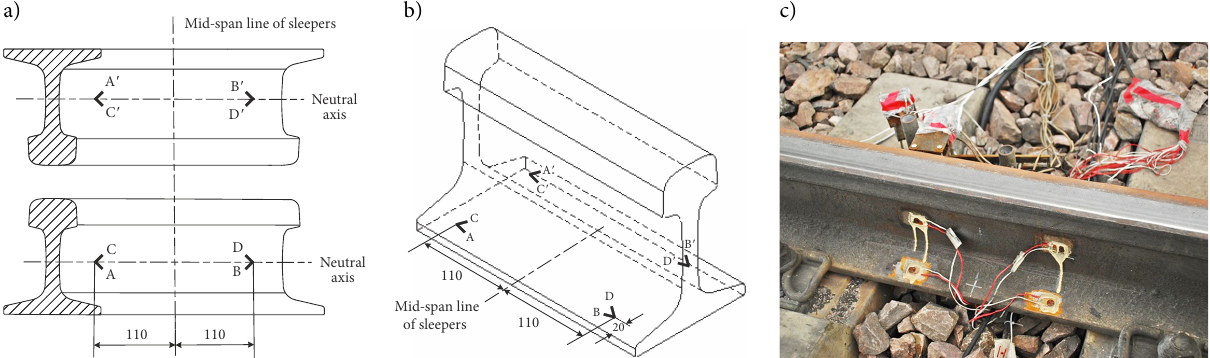
Figure 4. Wheel–rail dynamic force test scheme: a – strain gauge arrangement for vertical force measurement; b – strain gauge arrangement for lateral force measurement; c – photo of the field testing